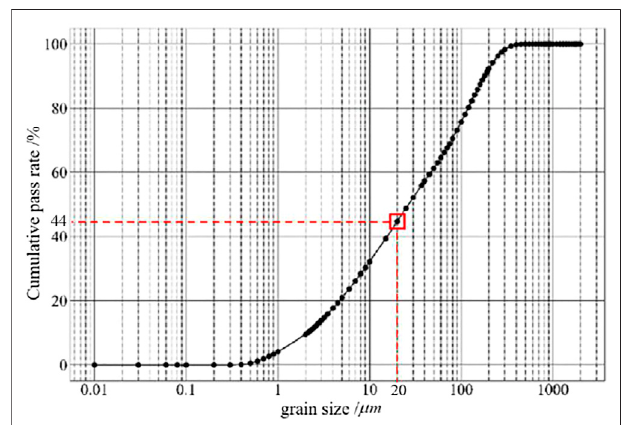
FIGURE 1 | Particle size distribution curve of